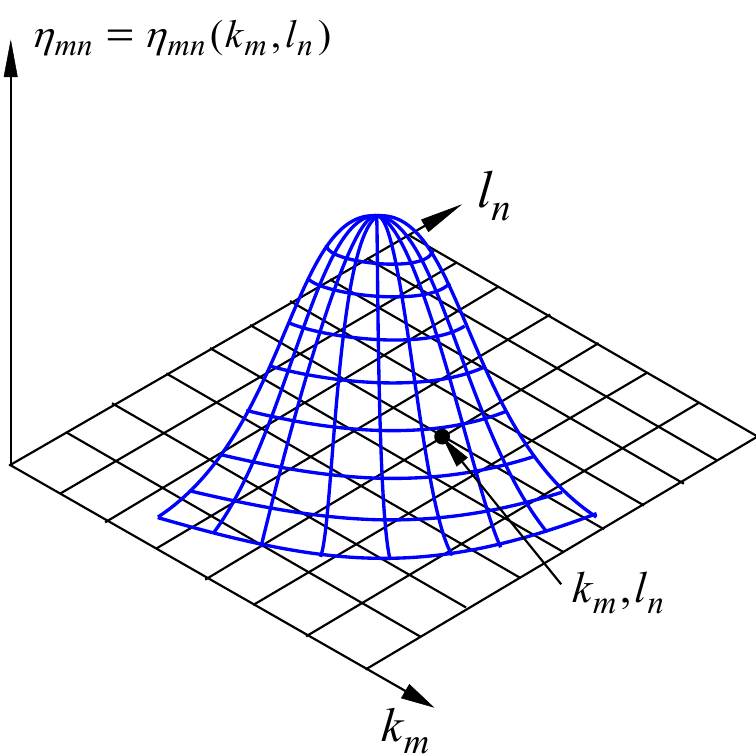
Figure 18. Ocean surface wave elevation in two dimensions at an instant in time,  ( x m , y n , t  0) , on a grid of coordinate points ( x m , y n ) , with spatial resolution (  x ,  y ) .